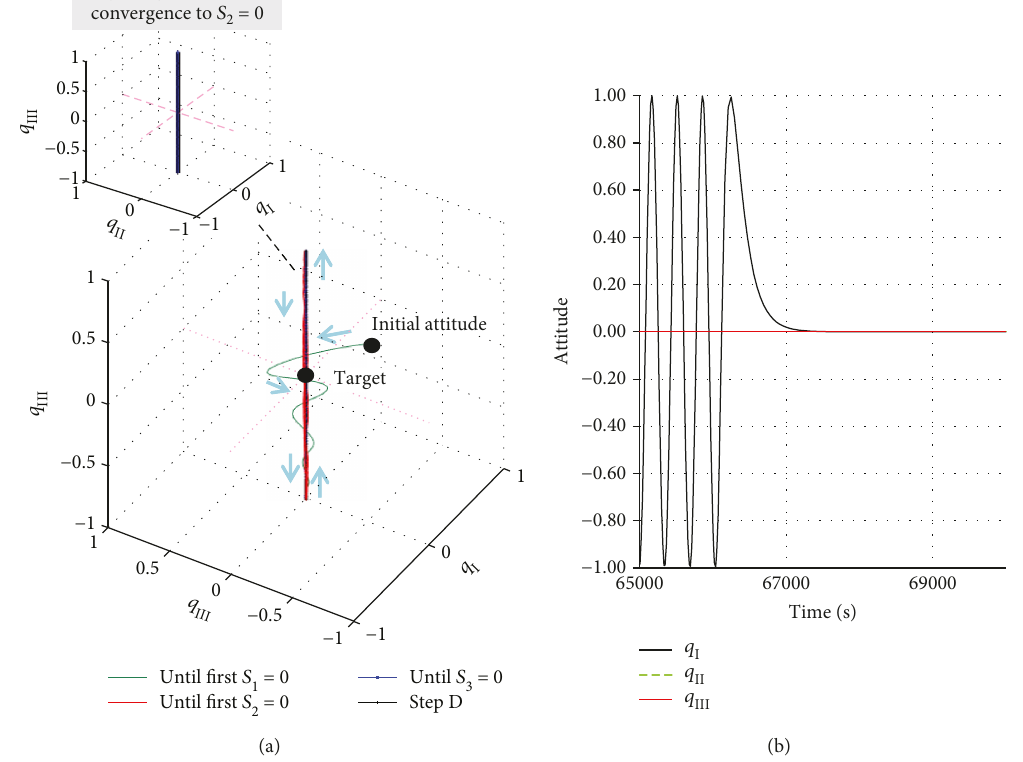
Figure 13: Attitude in case 3. (a) Attitude trajectory to the target. (b) Attitude history around the